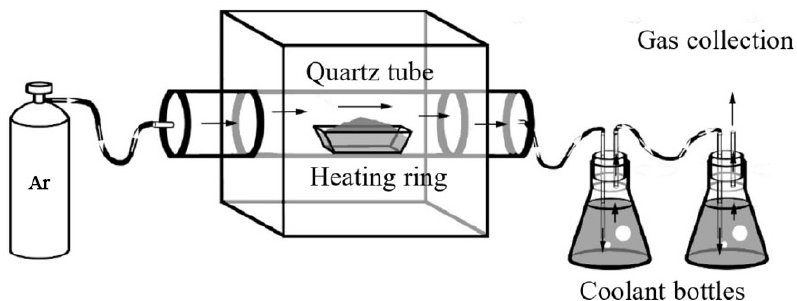
Figure 1. Schematic of lab-scale soil heating